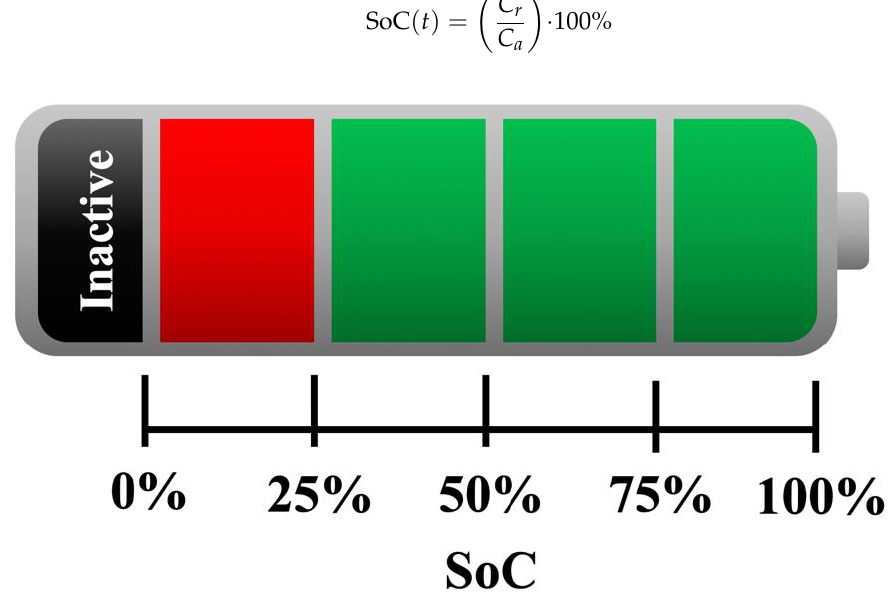
Figure 2. Stored energy status of a lithium-ion battery related to state-of-charge.